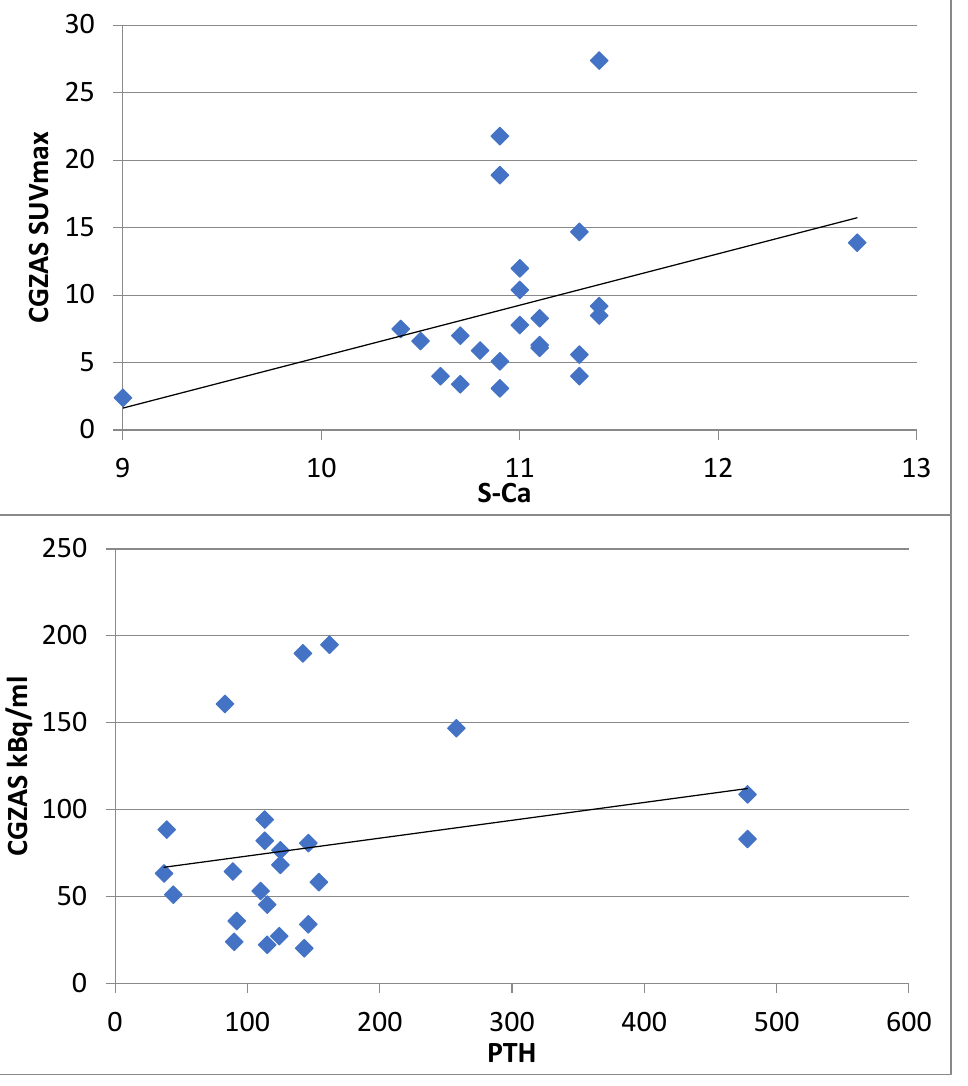
Figure 6. The correlations between serum parathormone ( upper ) and calcium ( lower ) concentration and quantitative SPECT. The correlation is weak, p < 0.05.